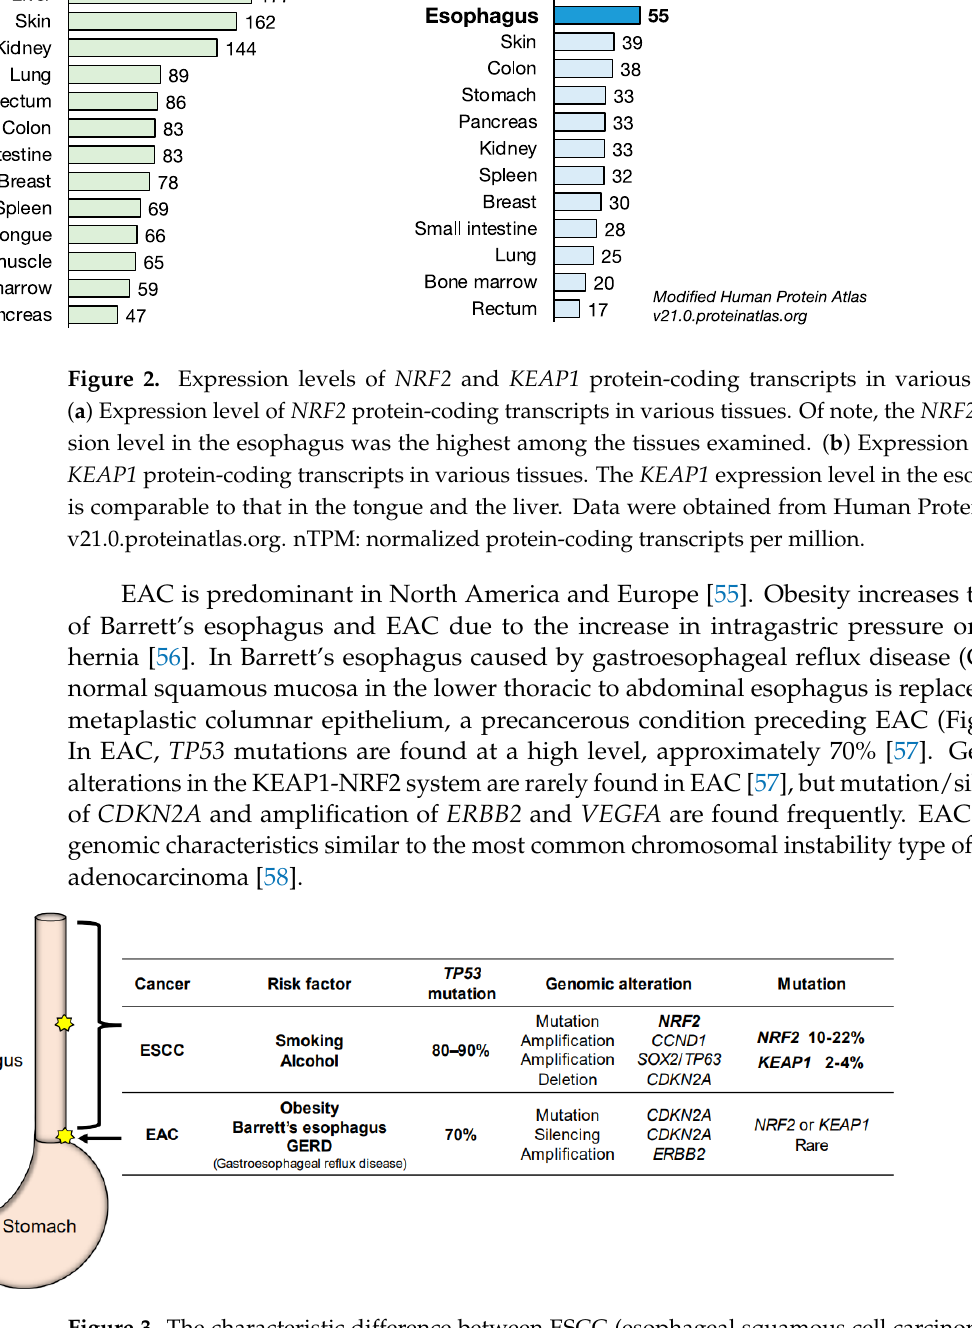
Figure 3. The characteristic difference between ESCC (esophageal squamous cell carcinoma) and EAC (esophageal adenocarcinoma). Most cases of ESCC occur in the middle thoracic esophagus, and ESCC is highly associated with smoking and alcohol consumption. Somatic mutations of NRF2 are often found in ESCC. EAC occurs in the lower thoracic esophagus, down to the esophagogastric junction. EAC originates from Barrett’s esophagus and GERD (gastroesophageal reflux disease). Genomic alterations in the KEAP1-NRF2 system are rarely found in